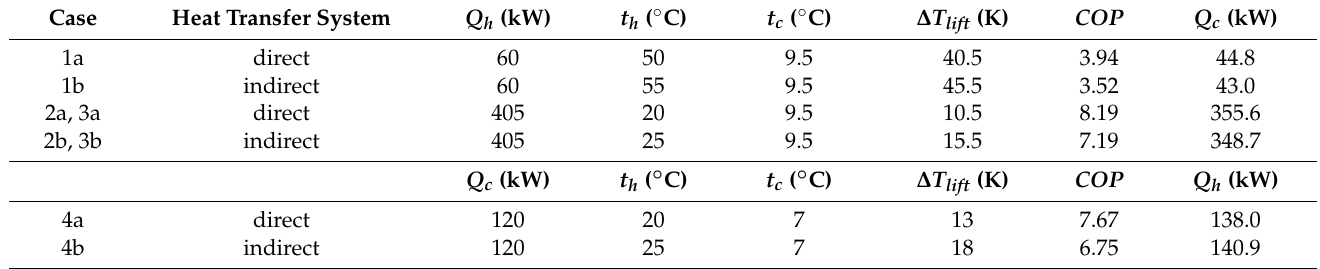
Table 6. Calculation results for the required capacity of the heat pump’s heat source and